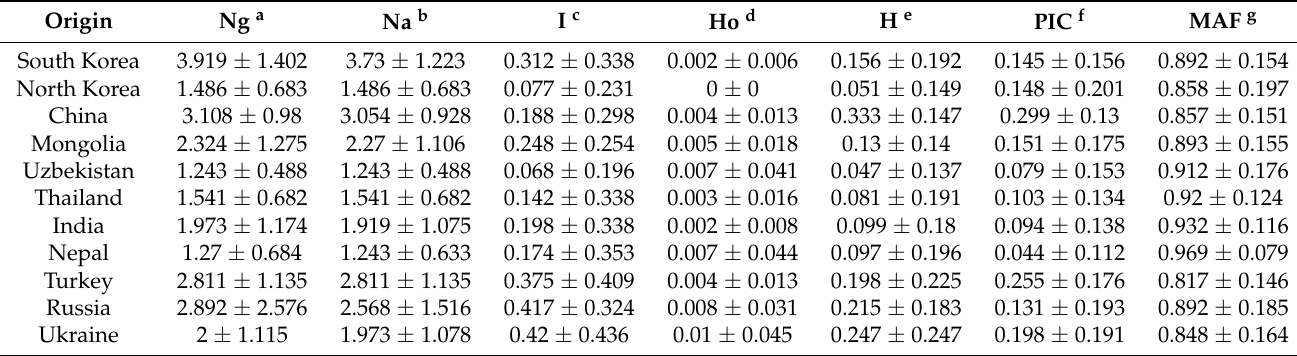
Table 2. Genetic diversity information of each origin